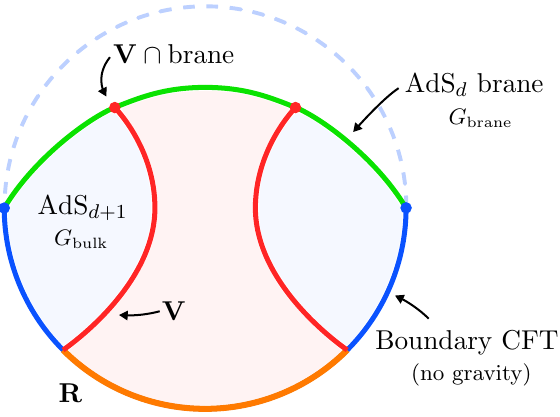
Figure 1 . A sketch of our holographic setup illustrating the various elements appearing in eq. (1.3), which manifests the island rule in our